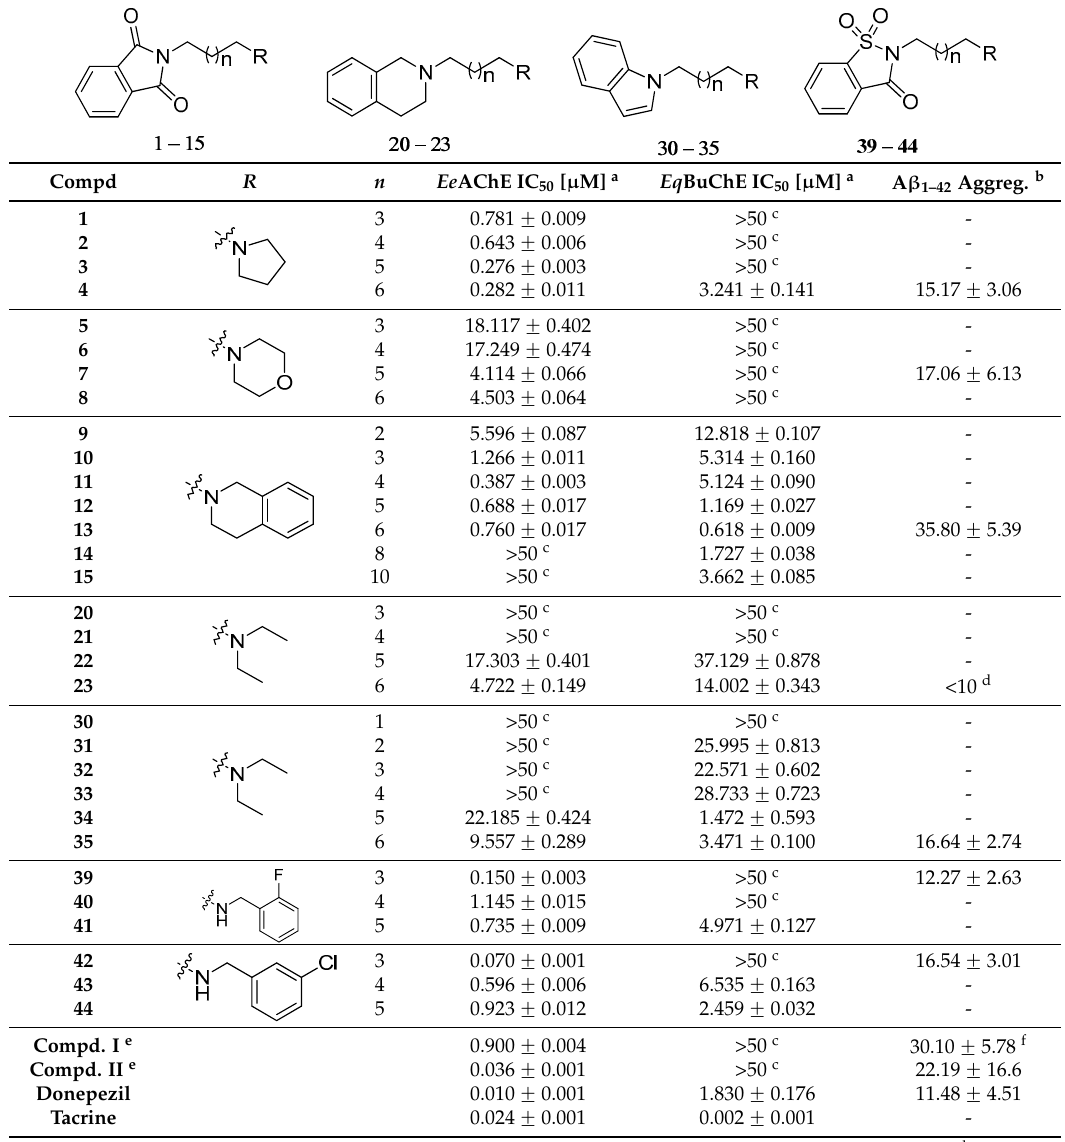
Table 1. Inhibitory potency of the synthesized compounds against Ee AChE, Eq BuChE and against A β 1–42 aggregation.